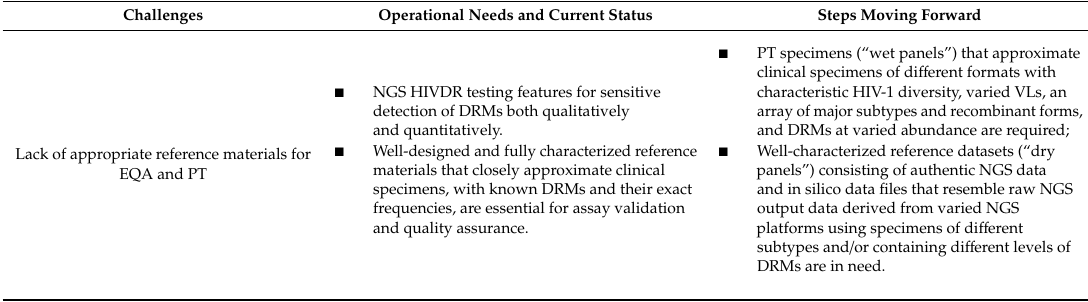
Table 2. Challenges for the generalized application of NGS-based HIV drug resistance (HIVDR)